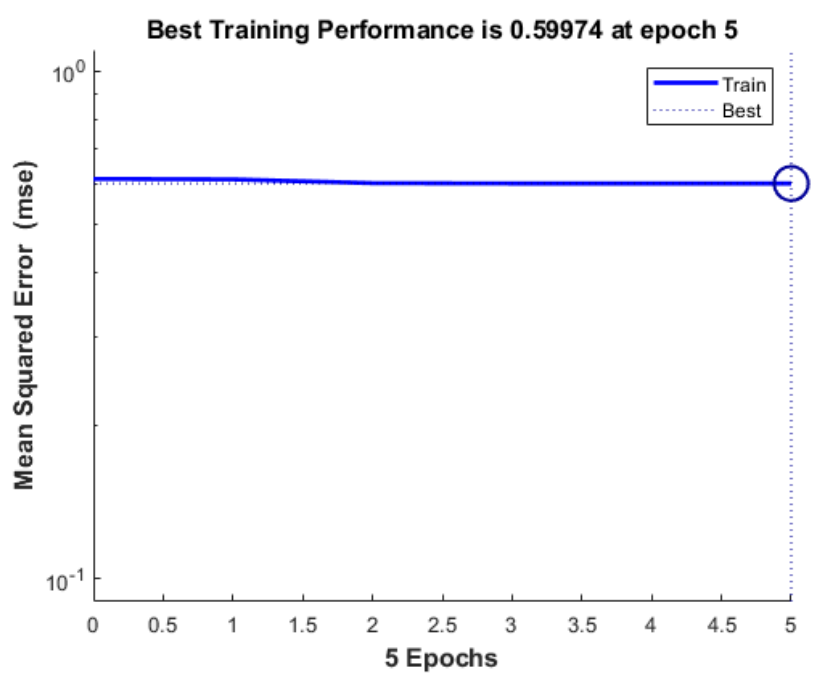
Figure 42. Neural network controller training performance.